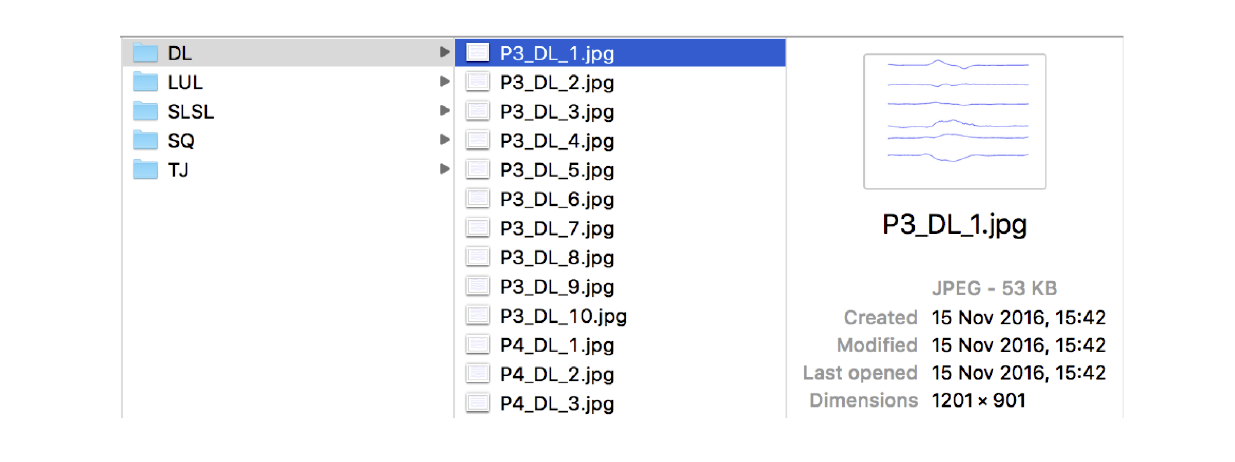
Figure 7. Folders containing images for the five exercises (Bodyweight squat: SQ, bodyweight lunge: LUL, barbell deadlift: DL, single leg squat: SLSL, and tuck jump: TJ).